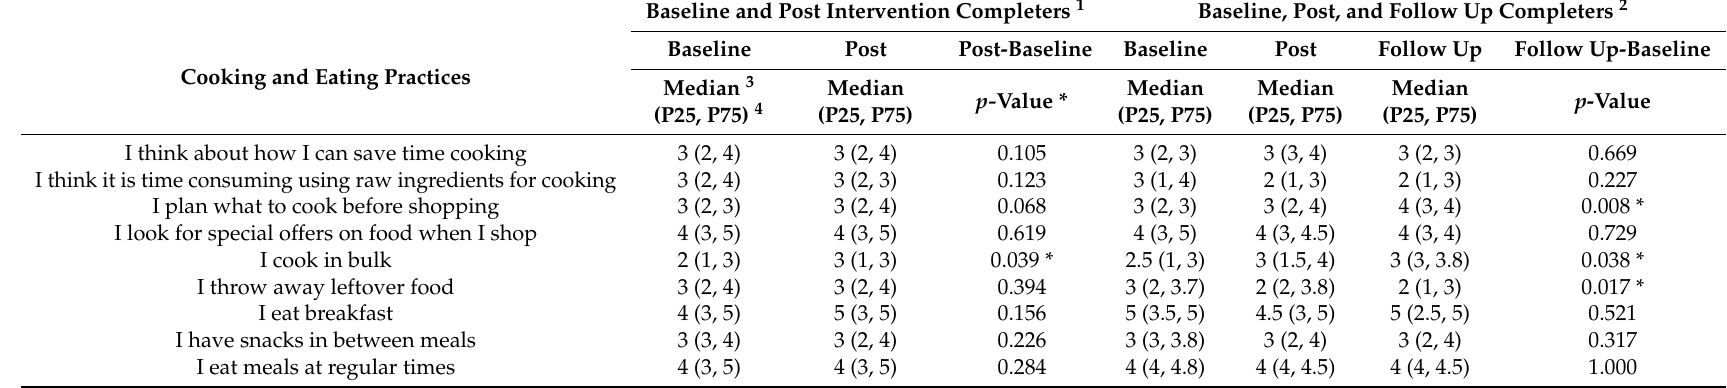
Table 2. Median values for food preparation, cooking, and eating practices at baseline, post-intervention ( n = 62), and 3–4 months follow up ( n = 17). Baseline and Post Intervention Completers 1 Baseline, Post, and Follow Up Completers 2 Baseline Post Post-Baseline Baseline Post Follow Up Follow Up-Baseline Cooking and Eating Practices Median Median 3 p- Value (P25, P75) (P25, P75) 4